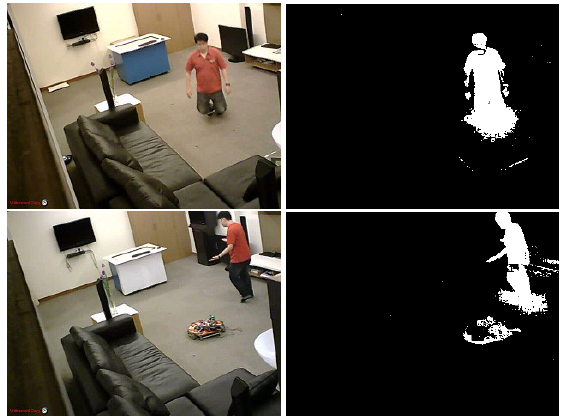
Figure 2. Codebook background subtraction